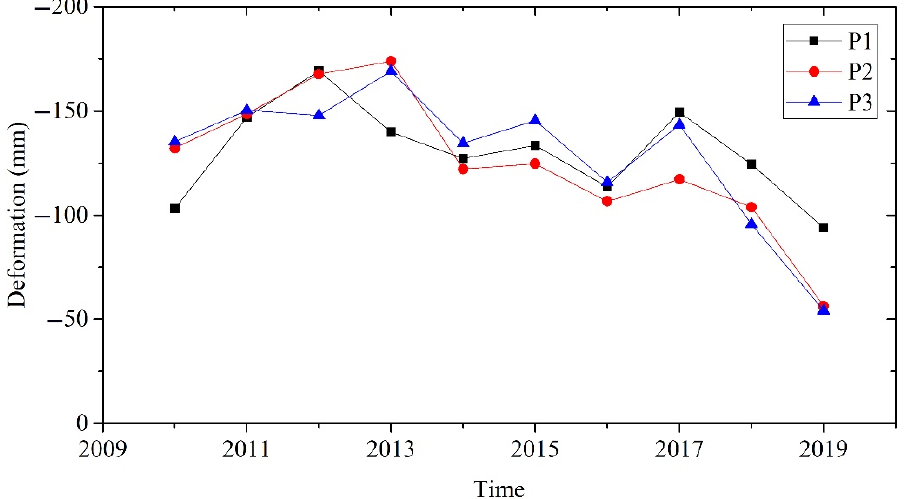
Figure 10. Time series displacement at three typical deformation centers.